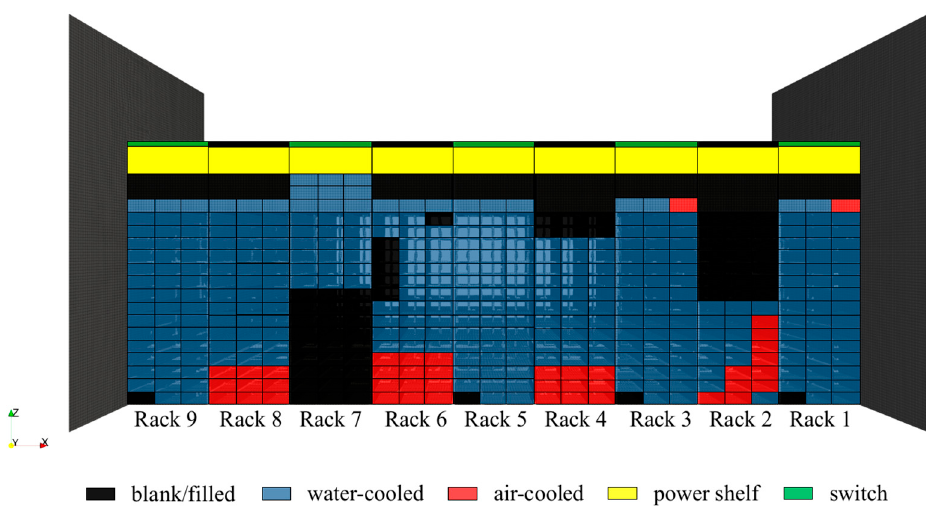
Figure 8. Layout of the Blockheating Data Center.